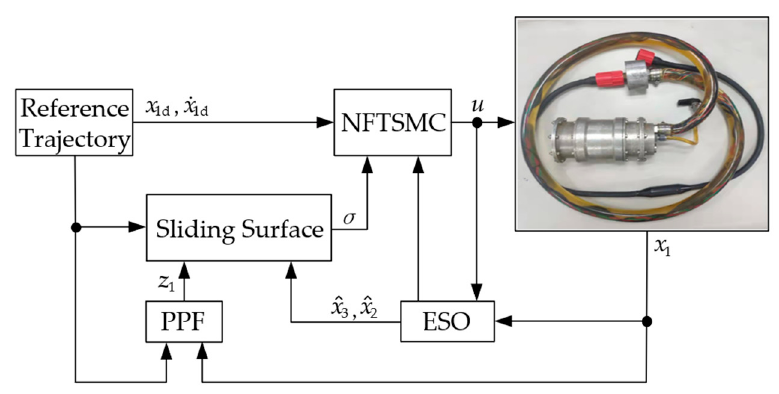
Figure 2. The block diagram of the proposed PP-NFTSMC-ESO